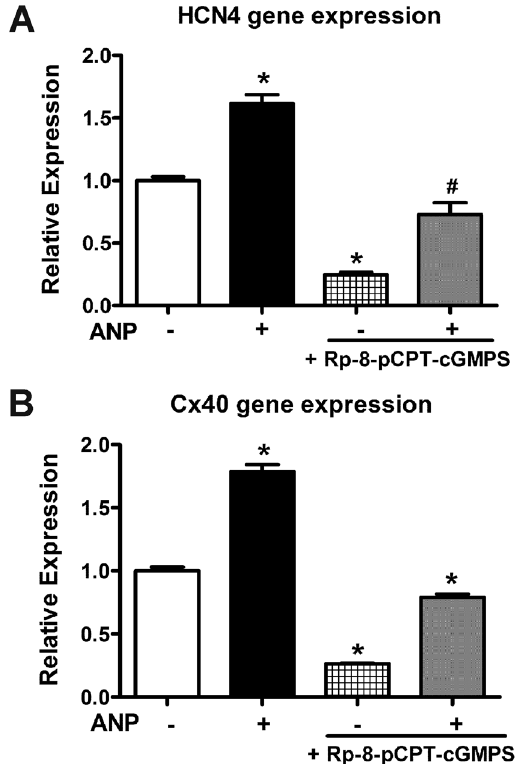
Figure 8. Gene expression of conduction system markers in E11.5 cultures treated with or without ANP and a PKG inhibitor, Rp-8-pCPT-cGMPS. RT-qPCR analysis was used to monitor HCN4 ( A ) and Cx40 ( B ) gene expression levels in cells treated with ANP (1 μ g/ml) and or a PKG inhibitor, Rp-8-pCPT-cGMPS (100 µ M) for 24 hours. Expression levels were normalized to GAPDH via ∆∆ C T method. Relative expression levels were presented as fold changes in comparison to the levels in untreated cultures (No ANP or PKG inhibitor). Addition of Rp-8-pCPT-cGMPS alone significantly reduced HCN4 and Cx40 gene expression. Co-treatment with ANP partially rescued the inhibitory effects of Rp-8-pCPT-cGMPS on VCS marker gene expression. N = 8 independent experiments per group, each bar represents mean ± SEM, * P < 0.005 Vs. all groups in both panels, # P < 0.05 Vs. Cont (No ANP and No PKG inhibitor) and 0.005 Vs. all other groups in panel A. One-way ANOVA with Tukey’s multiple comparisons post hoc